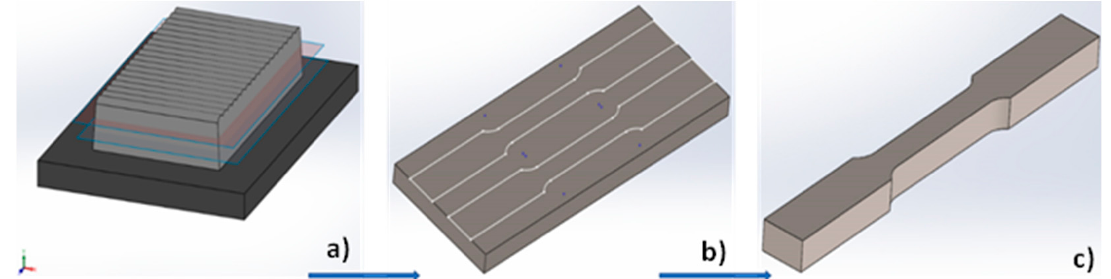
Figure 5. Tensile specimen extraction: ( a ) location of specimens on the block thickness; ( b ) two specimens of each block; ( c ) tensile specimen.